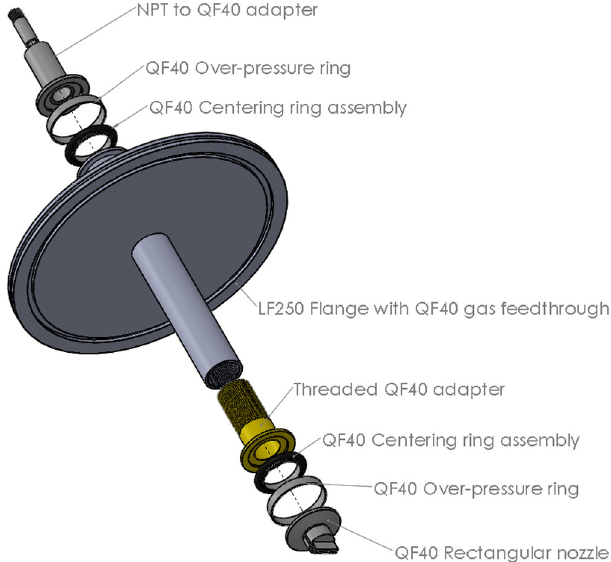
FIG. 5. Exploded view of the nozzle connection to the system. Wing nut clamps are not